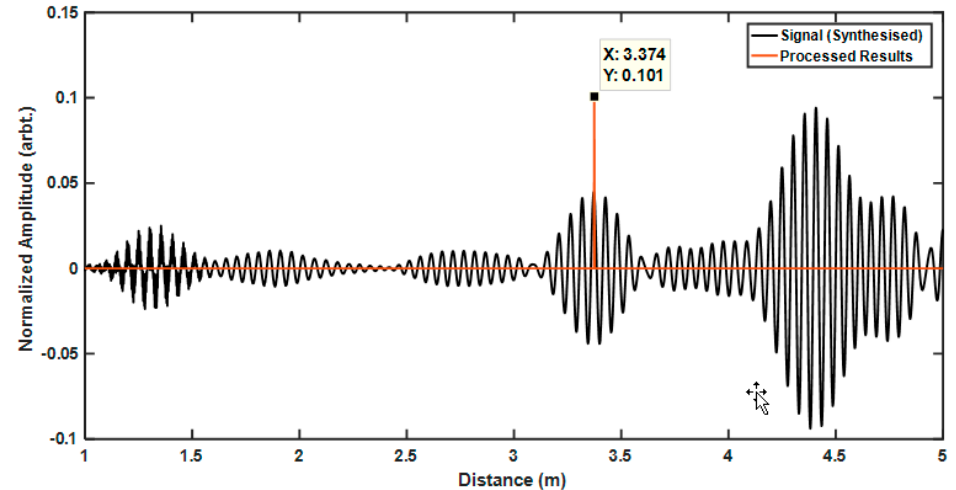
Figure 11. The final result (red line) overlaid on the time-domain signal (black line) from the FEM Case. The defect size is 3% cross-sectional area (CSA) and the excitation frequency is 30 kHz.